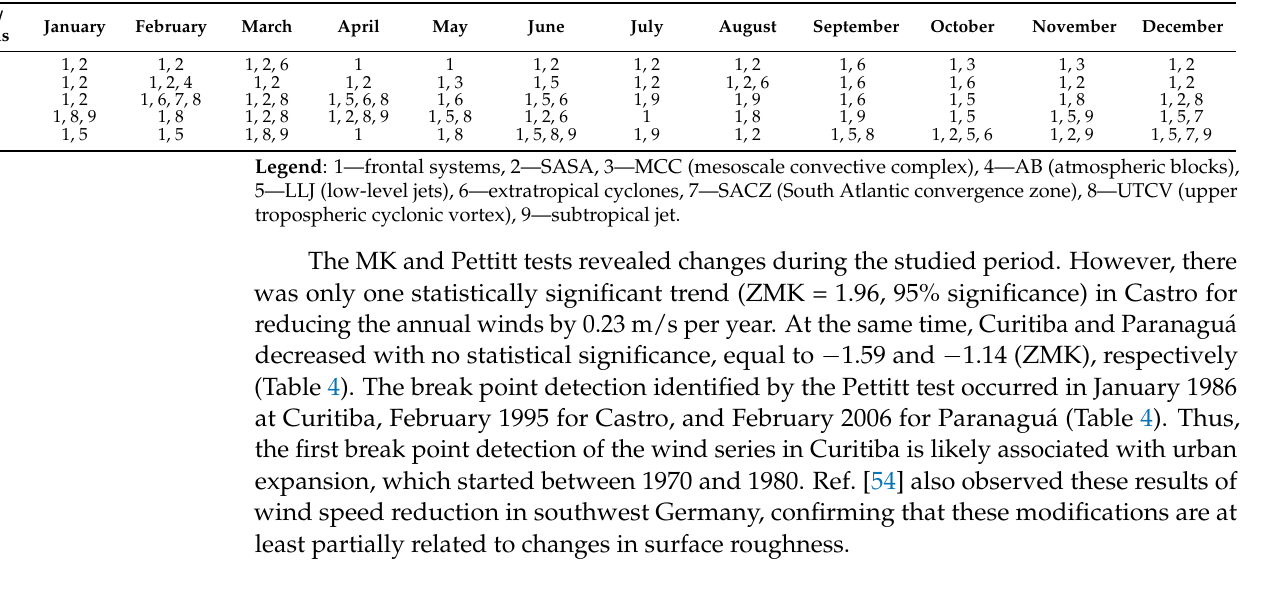
Table 4. Annual wind speed trend according to the Mann–Kendall test and break point detection (CPI) of the Pettitt